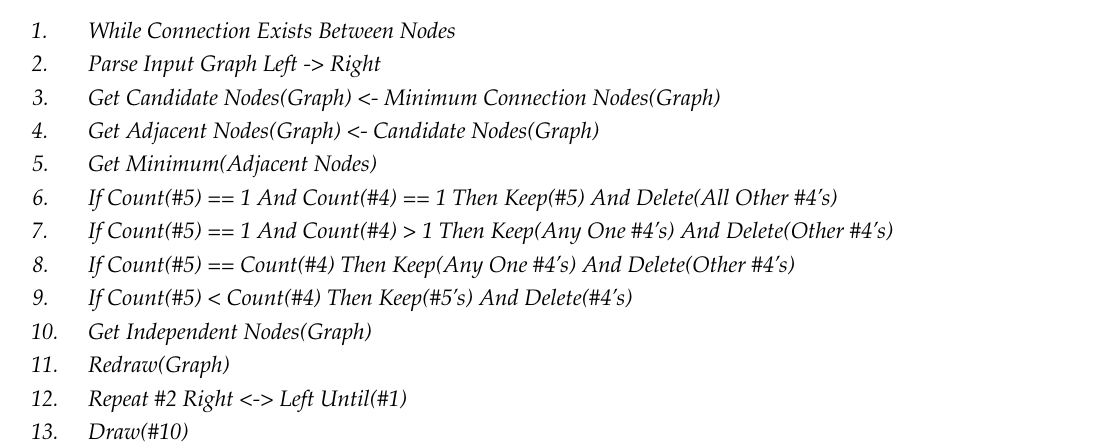
Algorithm 1. Defect tolerance algorithm with enhanced